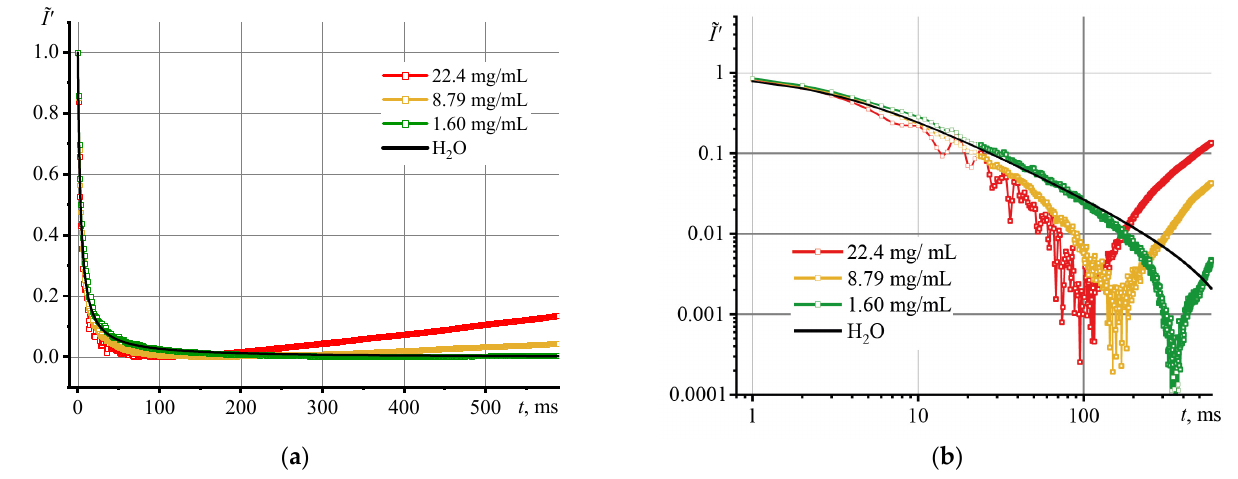
Figure 4. Transient curve, Equation (11), for dispersions of one series of NPs (HS, d av = 12 nm), but at different concentrations for the first 600 s of thermal lens development, ( a ) in linear and ( b ) logarithmic scales.